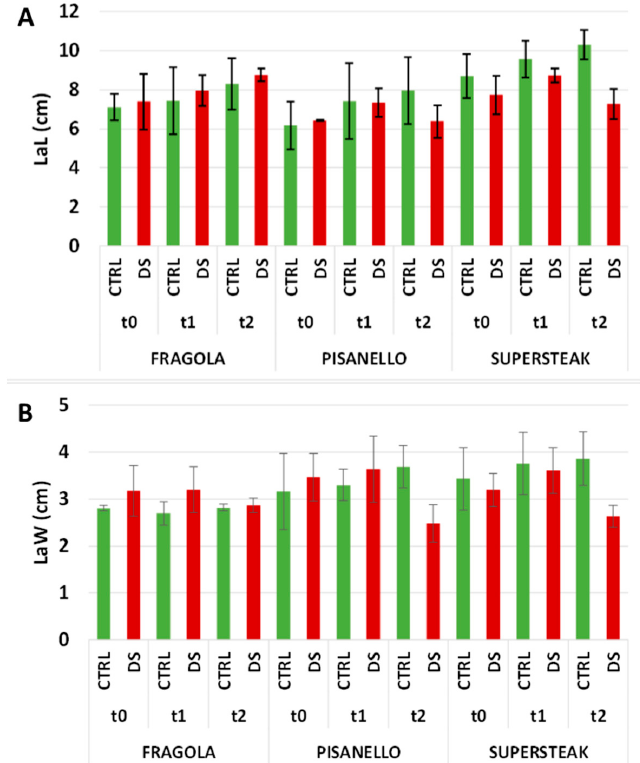
‘Pisanello’) and one commercial cultivar ‘Supersteak’ of tomato ( Solanum lycopersicum L.) subjected to drought stress (no water for 16 days) relative to the controls (regularly well-watered plants). Two- way factorial ANOVA followed by Tukey post-hoc test was used to determine the statistical significance of di ff erences. Points with the same lower-case letters do not di ff er significantly ( p > 0.05). t 0 = before the start of treatment, t 1 = half duration of the stress, t 2 = the end of the